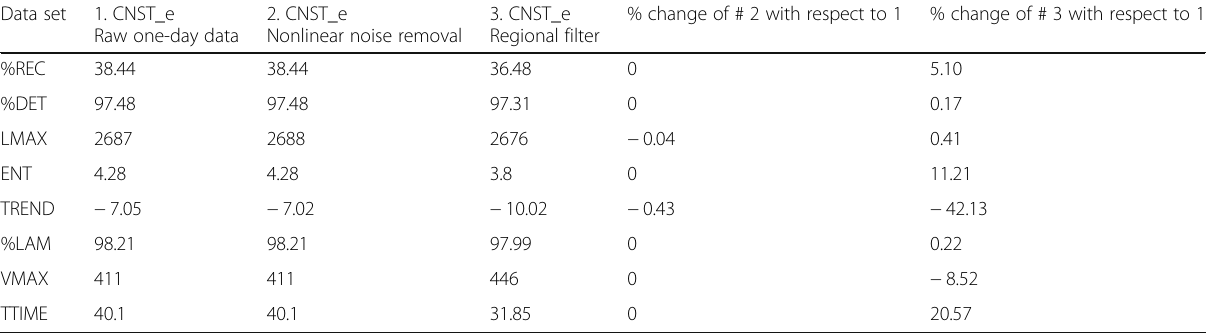
Table 4 Comparison of RQA measures for data set CNST_e, as raw data (column 1), with nonlinear noise reduction (column 2) and with noise reduction using the regional filter method (column 3; Beavan et al. 2004) Data